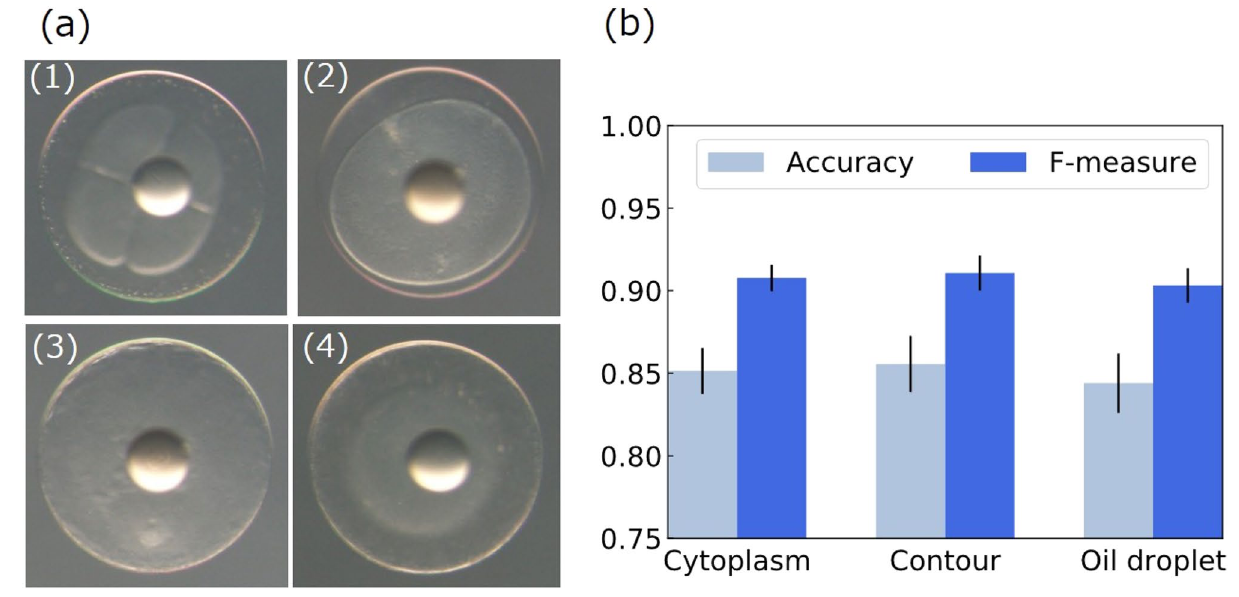
Figure 3. Result of NH prediction. ( a ) (1), (2), (3), and (4) were NH, NH, not NH, and not NH, respectively. The system predicted (1), (2), (3), and (4) as NH, NH, not NH, and NH, respectively. That is, the system successfully predicted for (1), (2), and (3). ( b ) Averages and standard errors of accuracy and F-measure for NH prediction in ten-fold cross-validation.